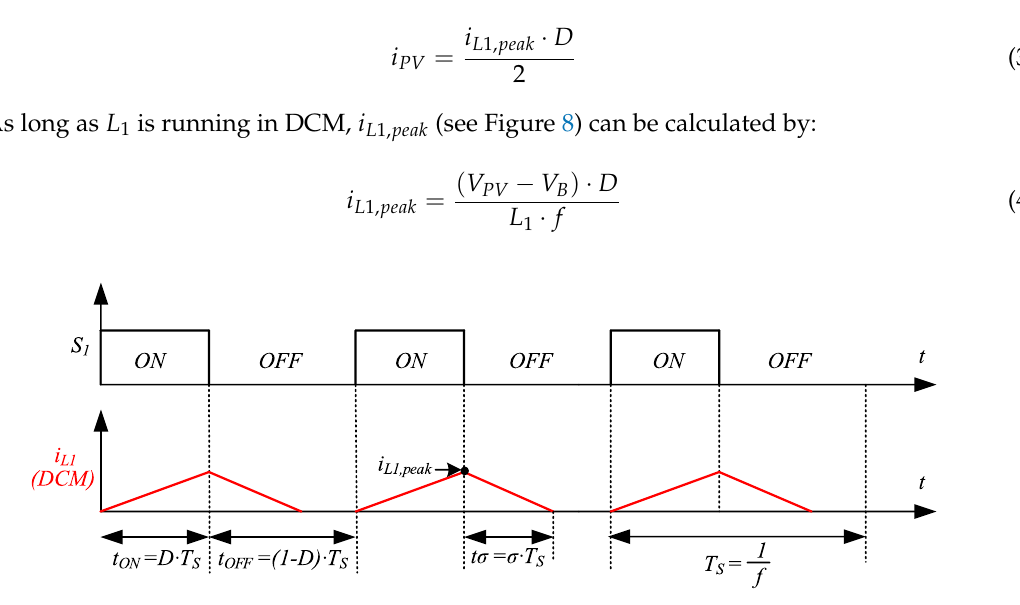
Figure 8. Waveform of the current i L 1 crossing the inductor L 1 in steady state, in Discontinuous Conduction Mode (DCM)